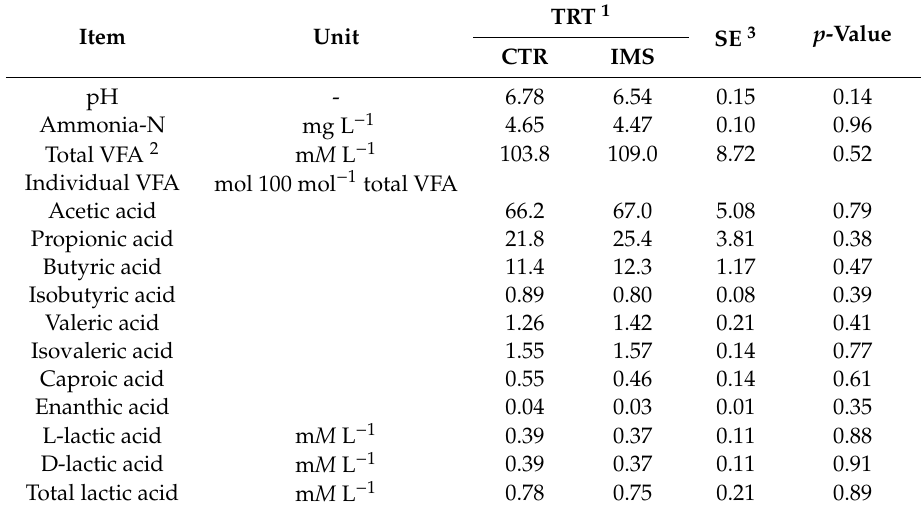
Table 3. Ruminal pH, ammonia concentrations and volatile fatty acids molar proportion, determined at 28 days after calving in control dairy cows (n = 5) or cows receiving 65 g*d − 1 of Omnigen-AF ® as top-dress between − 55 and 42 days from calving (n =